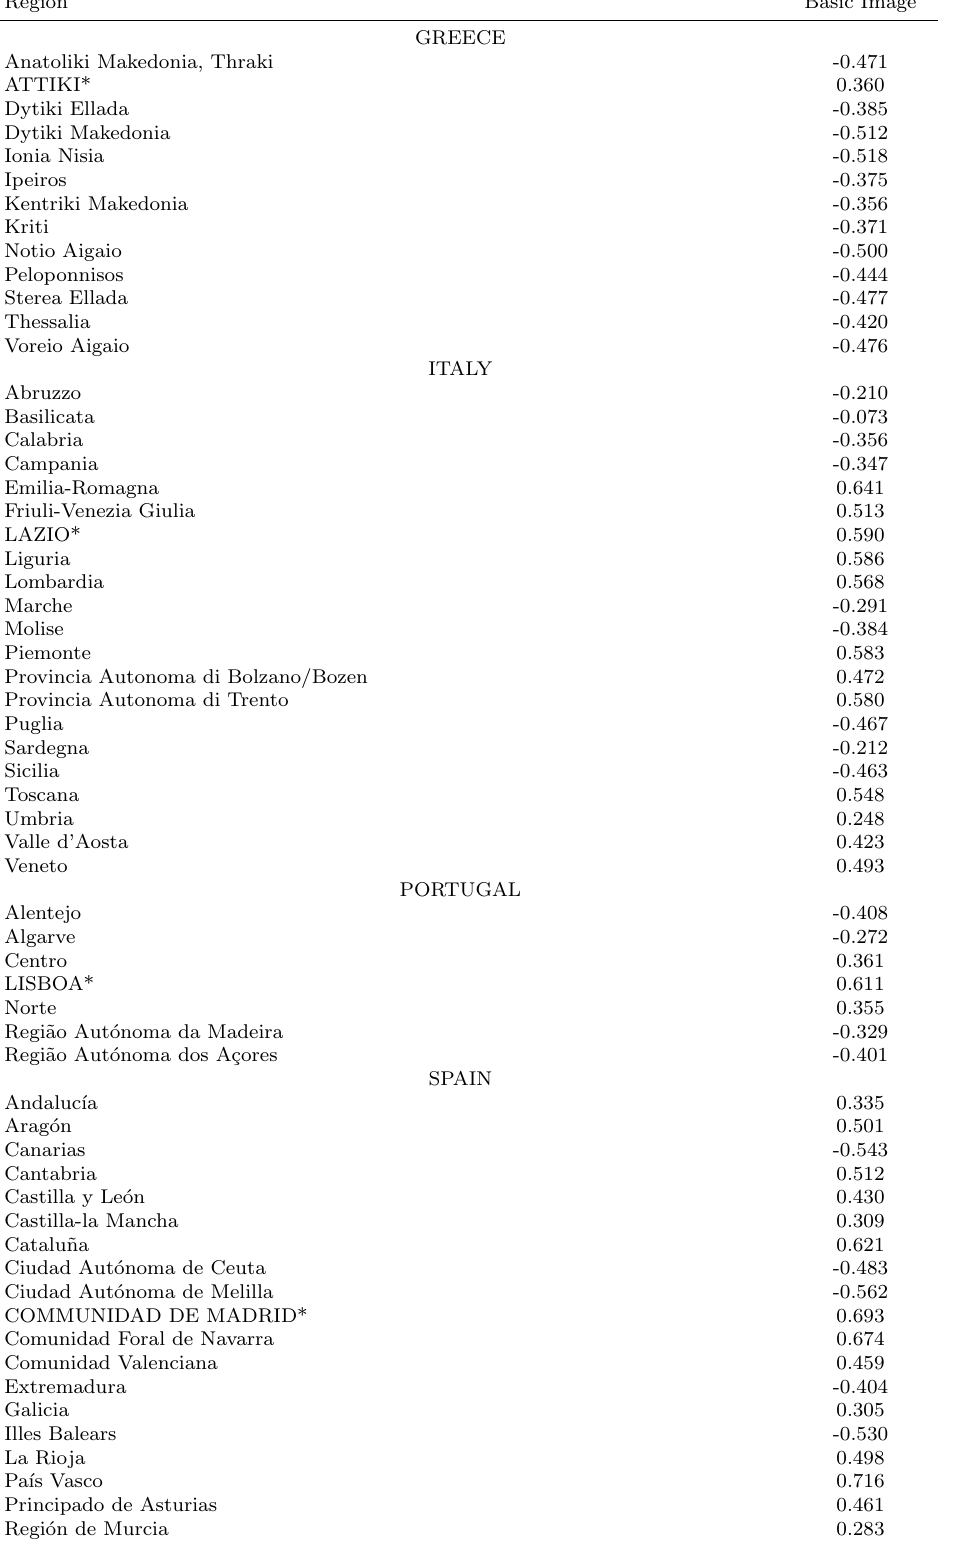
Table A.2: The Basic Image values of the south European regions